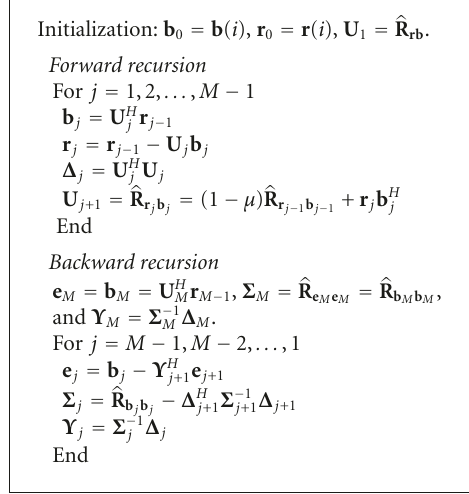
Algorithm 3: Recursion equations for the simplified M -stage MMWF